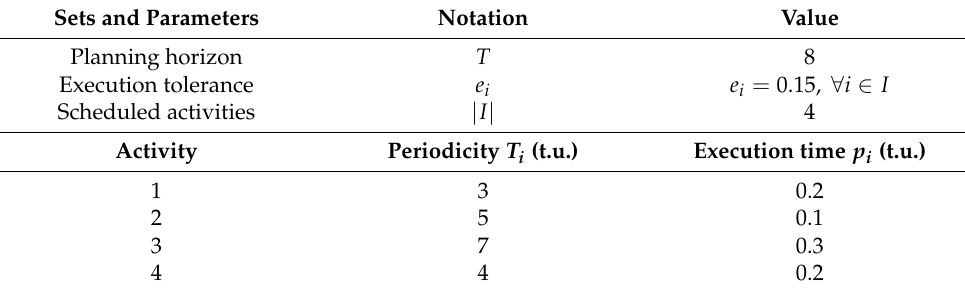
Table 2. Application example. Instance